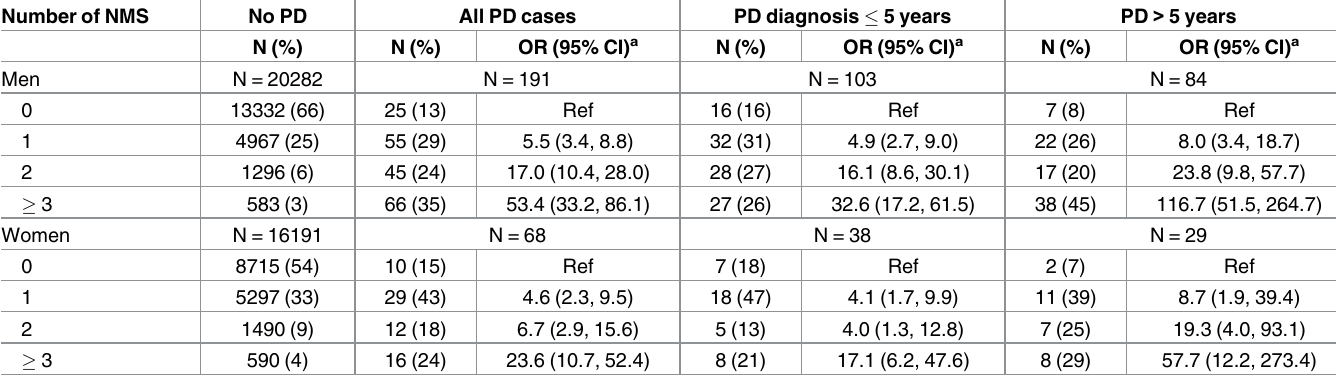
Table 5. Number of non-motor symptoms and Parkinson’s disease in the Agricultural Health Study.